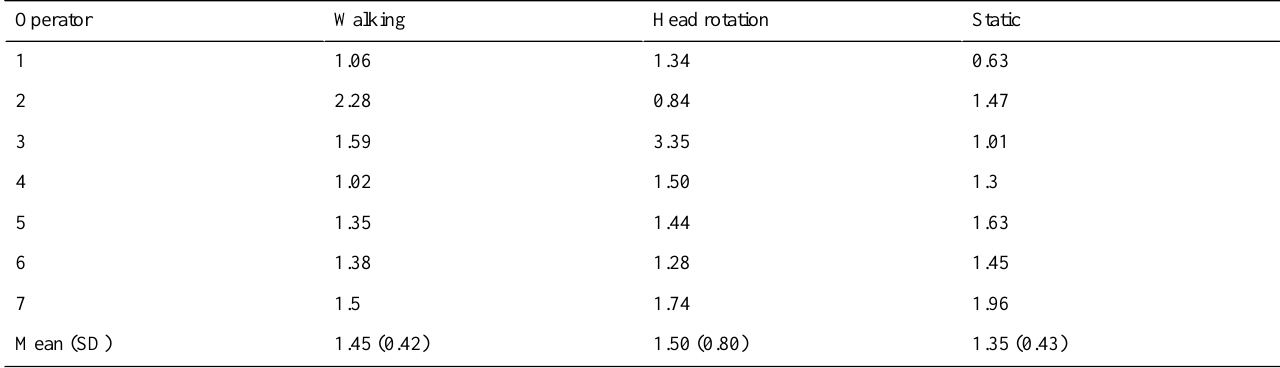
Table 5. Motion errors under an oblique angle without light